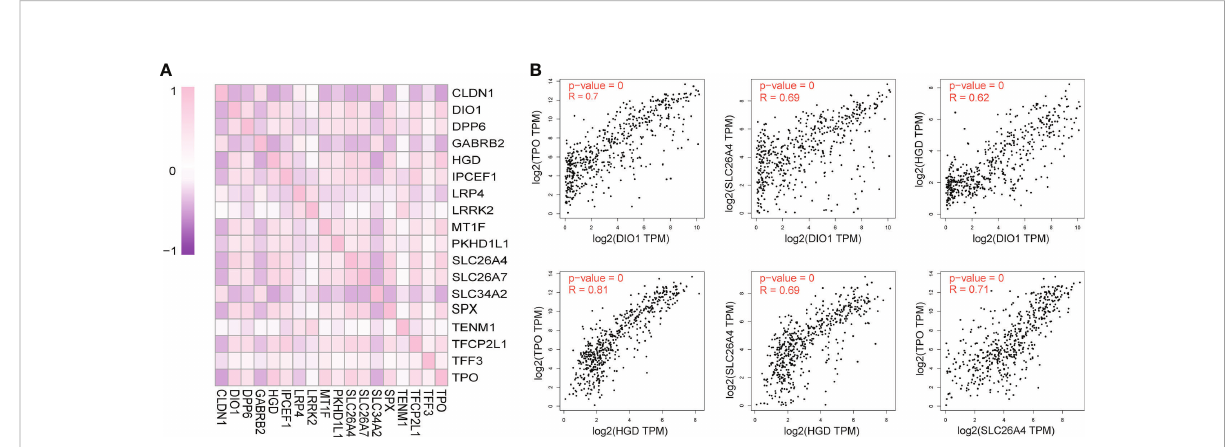
FIGURE 3 Pairwise correlation of differential expressed genes (DEGs) signi fi cantly affecting overall survival of TC patients in the context of TC disease. (A) R Software visualization of pairwise correlations of DEGs that signi fi cantly affected overall survival. (B) The correlation fi gure of DIO1 and TPO , DIO1 and SLC26A4 , DIO1 and HGD , HGD and TPO , HGD and SLC26A4 , TPO and SLC26A4